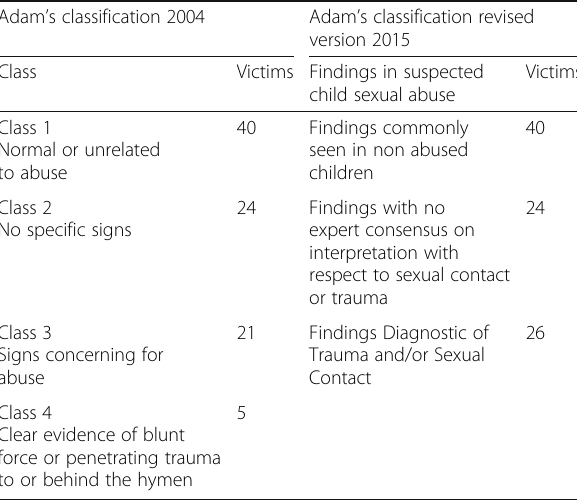
Table 1 Adam ’ s classification of the